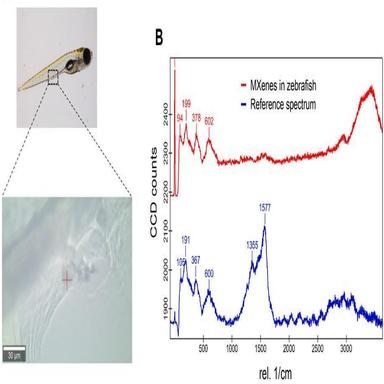
Uptake of MXenes confirmed by Raman confocal mapping. (A) Area of the zebrafish embryo scanned after exposure to MXenes (80 mg/L) for 24 h, and (B) high-resolution spectra of MXenes in the gut of zebrafish embryo after 24 h of exposure to MXenes in comparison to the reference spectra of the MXenes alone using 1800 grating.